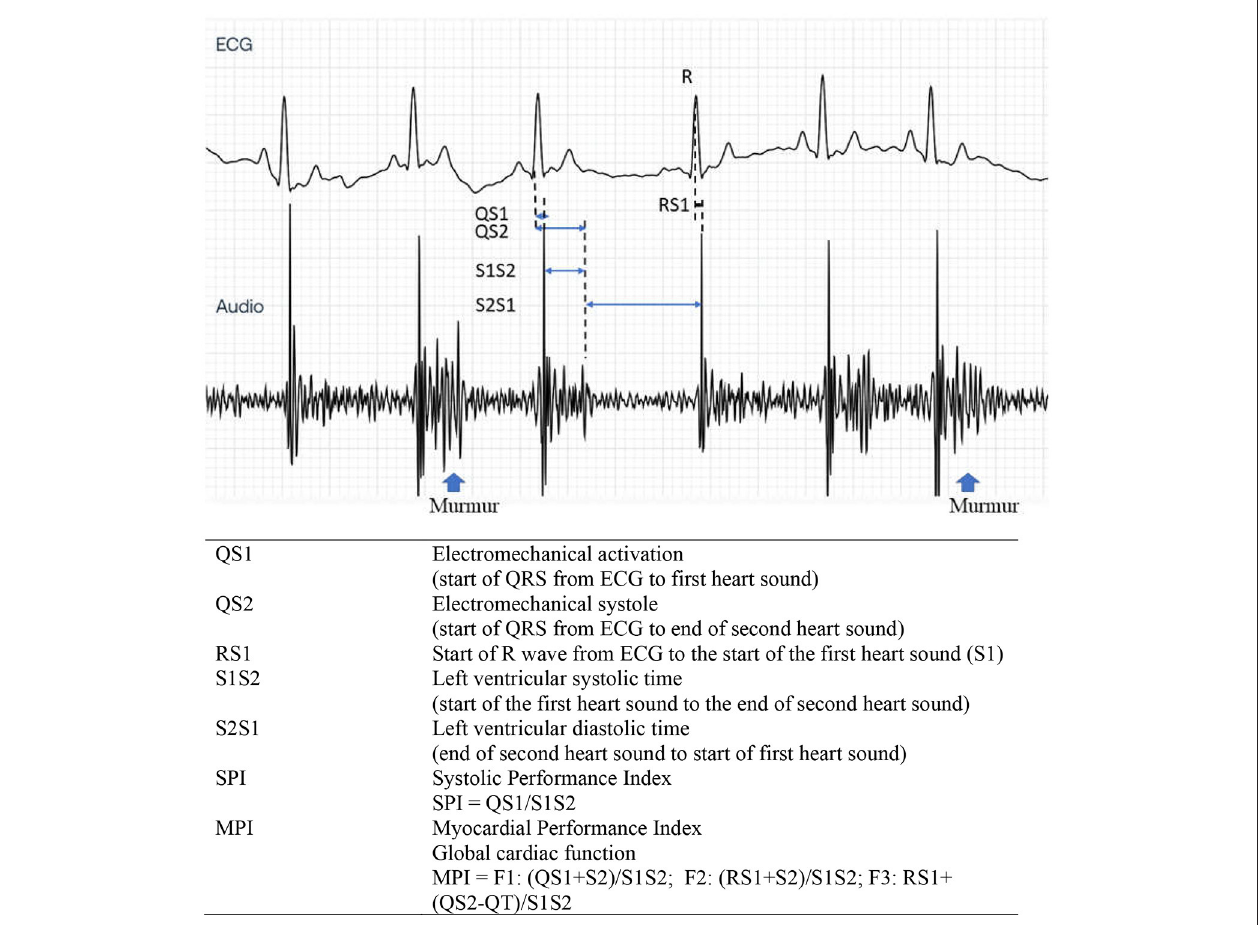
FIGURE 3 | Representative tracing of ECG (top) and PCG (bottom) from the Eko analyzing software. Cardiac time interval recording and its description from a dog with stage C MMVD with heart murmurs. PCG, phonocardiography; MMVD, myxomatous mitral valve